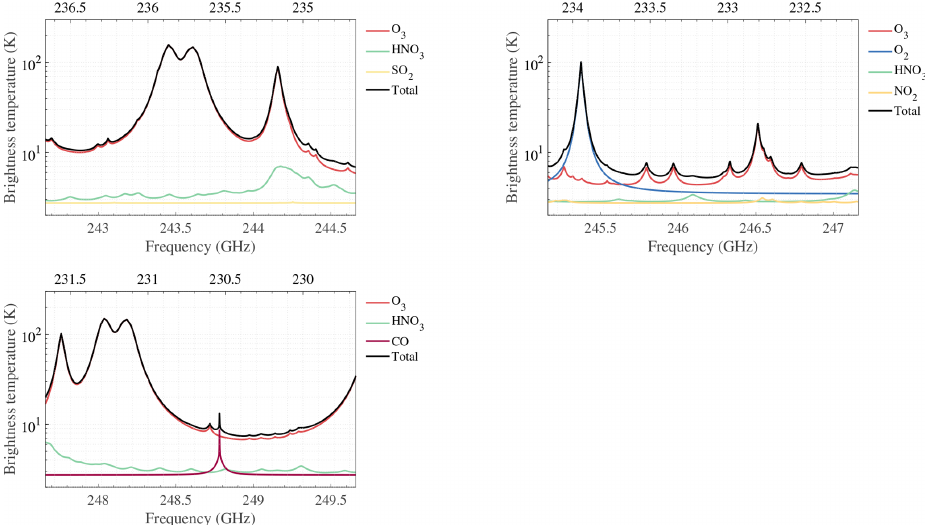
Figure 6. Contributions of the main target chemical species to the 240GHz spectra. The brightness temperature is measured from the double- sideband radiometer. The tangent height is 30km. The top axis represents the lower sideband frequencies and the bottom axis represents the upper sideband frequencies. Each panel represents a single